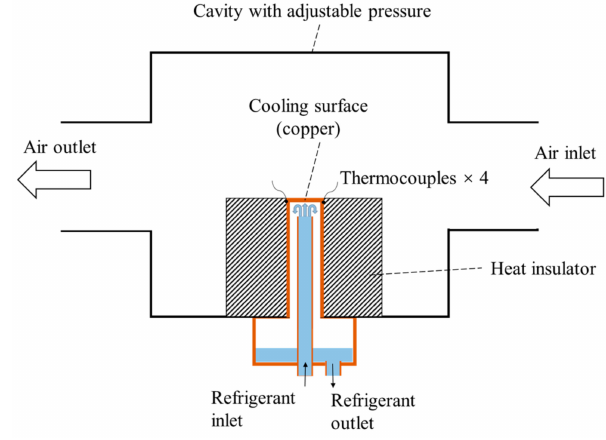
Figure 2. Schematic diagram of test cavity with adjustable pressure.